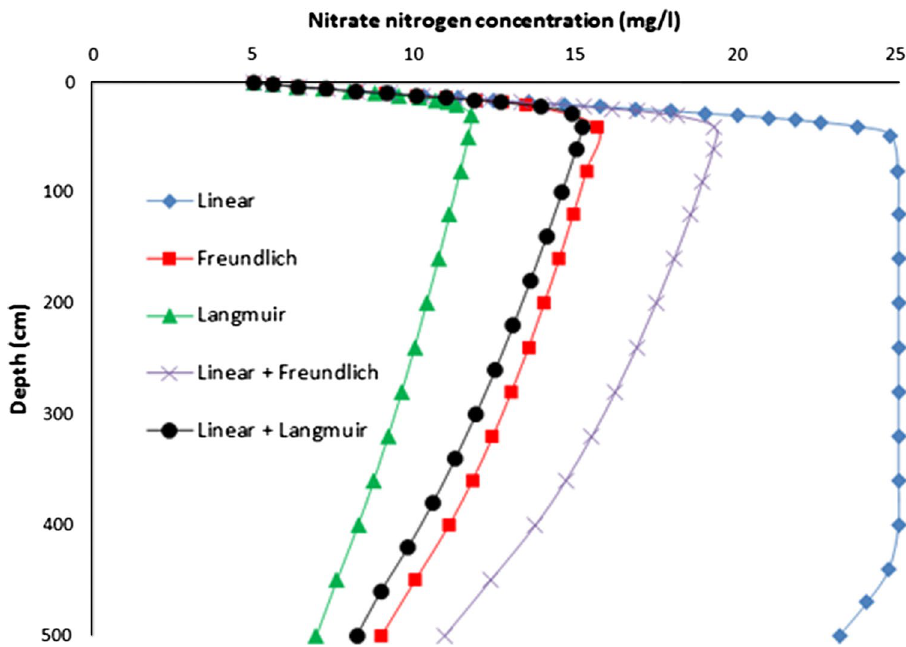
Fig. 5 Concentration profile for nitrate nitrogen with linear, Freundlich and Langmuir iso- therms at the end of 50 days of wastewater application (refer to Tables 2 and 3 for other data)